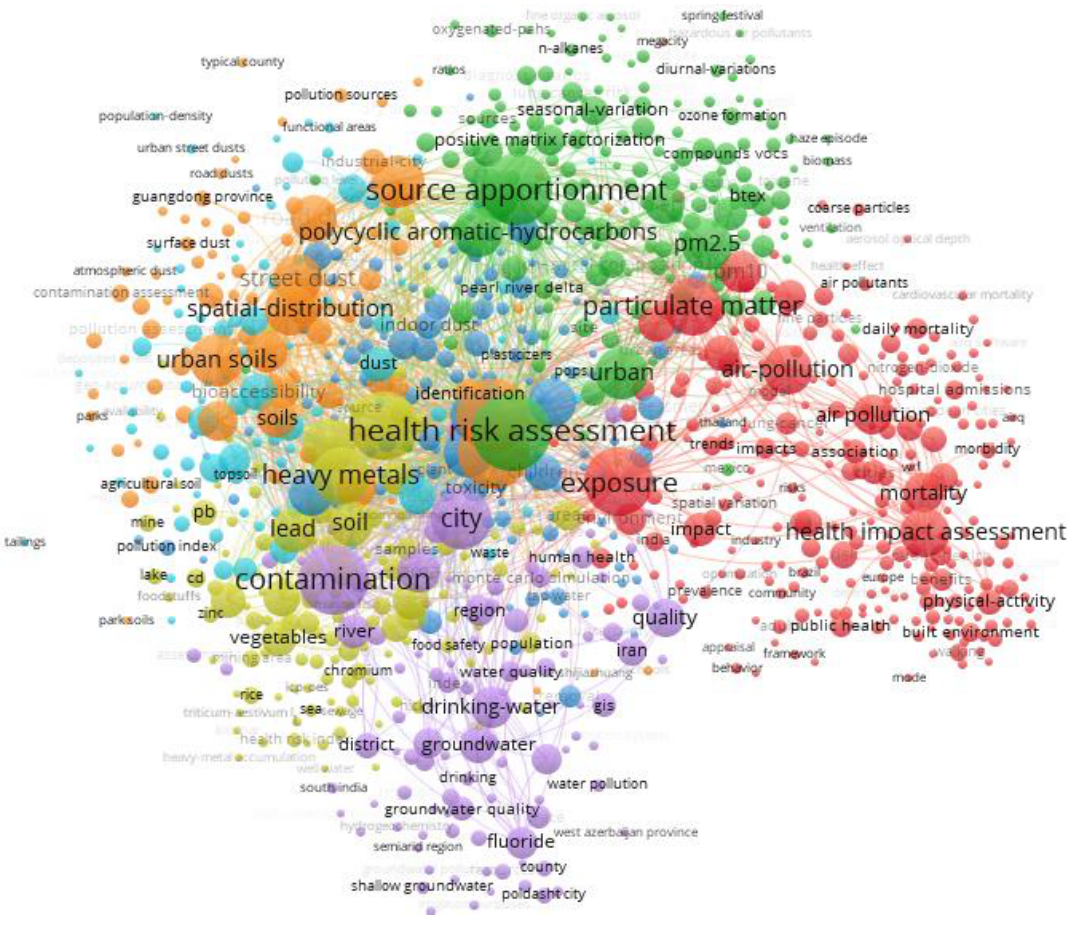
Figure 7. The keyword co-occurrence network.